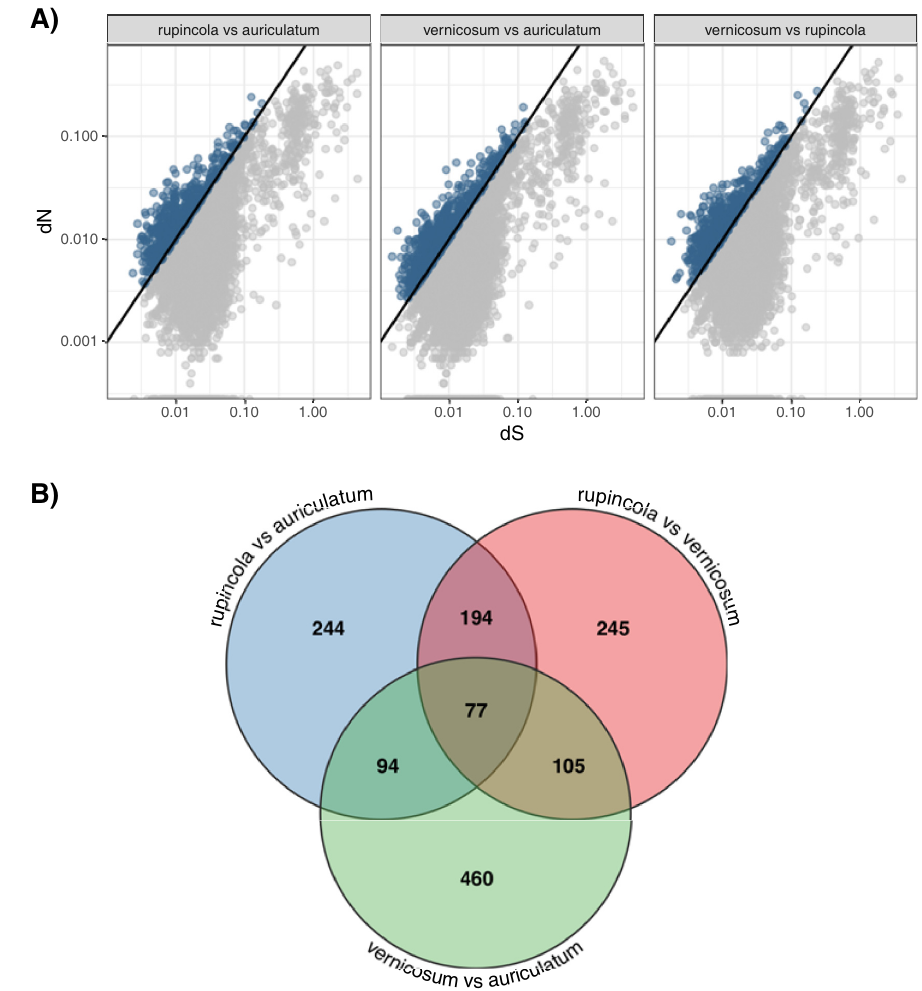
Fig 4. Comparative transcriptome sequence analysis of synonymous and non-synonymous nucleotide substitutions of the three Rhytidophyllum species. A) Plot of dN/dS ratio for each pairwise species comparisons. The line indicates the 1:1 slope and blue points represent open reading frames (ORFs) that have a dN/dS > 1. B) Venn diagram showing the ORFs that were found significant in the different pairwise comparisons in A. 1,419 genes had a dN/dS > 1 among all pairwise species comparisons (Fig 4). Of these, we